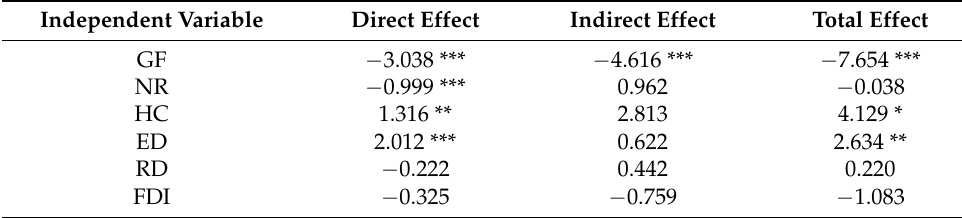
Table 5. The test results of the carbon emission reduction effect of green finance. Independent Variable Direct